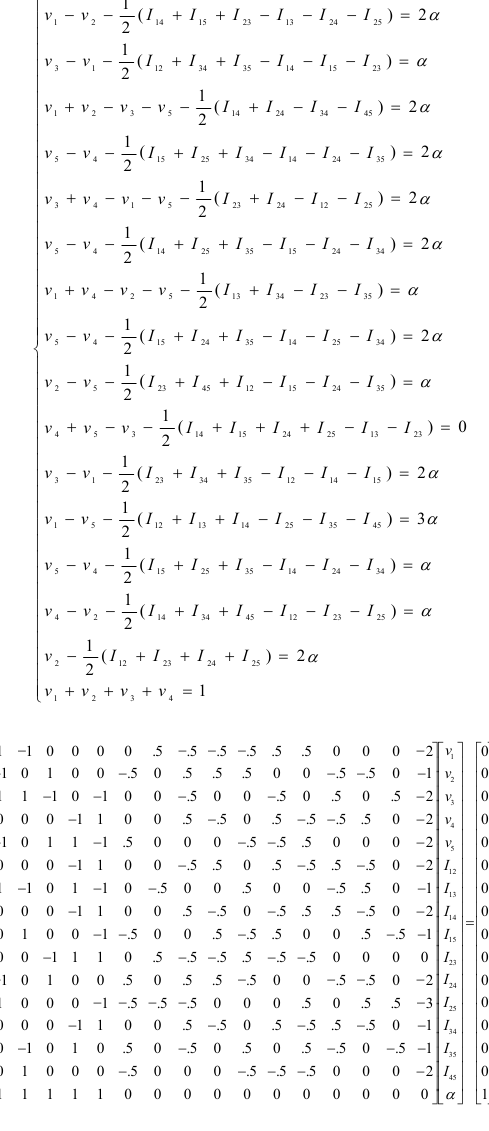
Table 5.2. Aggregated performance of the